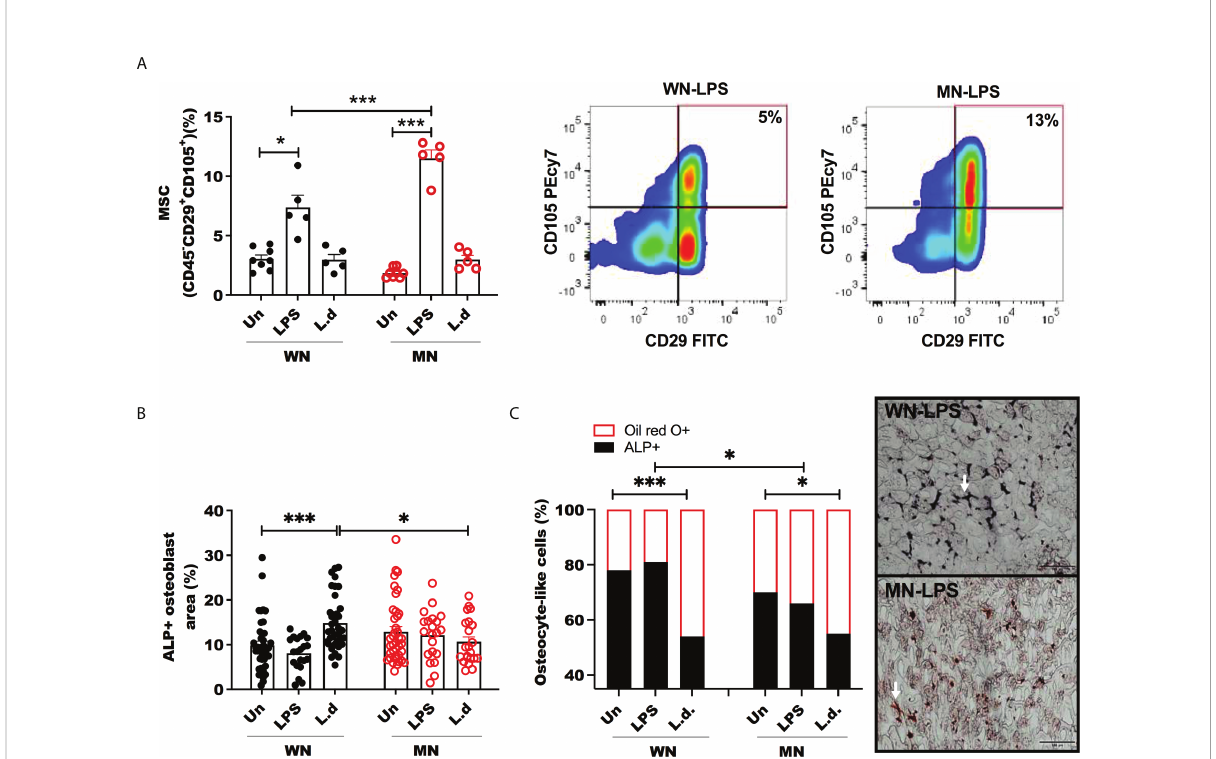
FIGURE 3 Mesenchymal stem cells are increased but osteoblasts unchanged in LPS challenged malnourished mice. Well-nourished (WN) or malnourished (MN) mice were challenged with LPS or L. donovani ( Ld ) and compared with naïve unchallenged (Un) mice. L. donovani -challenged mice were evaluated at 72h post-challenge and LPS-challenged mice were evaluated at 24h post-challenge. (A) Percentage of bone marrow mesenchymal cells (MSC) (CD45 - CD29 + CD115 + ) relative to total bone marrow cells and representative plot by fl ow cytometry (gated as S Figure 1). (B) Percentage of alkaline phosphatase positive area (ALP+) to identify osteoblasts in sternum cryosections. (C) Proportion of osteocyte-like cells in trabecular bone stained with Oil-Red O (Oil-red O +) or alkaline phosphatase (ALP+) in sternum cryosections. Right: Image showing osteocyte-like cells (white arrow) in trabecular bone double-stained with Oil-red O (red: lipid+) and alkaline-phosphatase (ALP+) (black: osteocyte), in sternum cryosections from LPS challenged mice. N=5 mice per group, 2 experiments.*p<0.05,